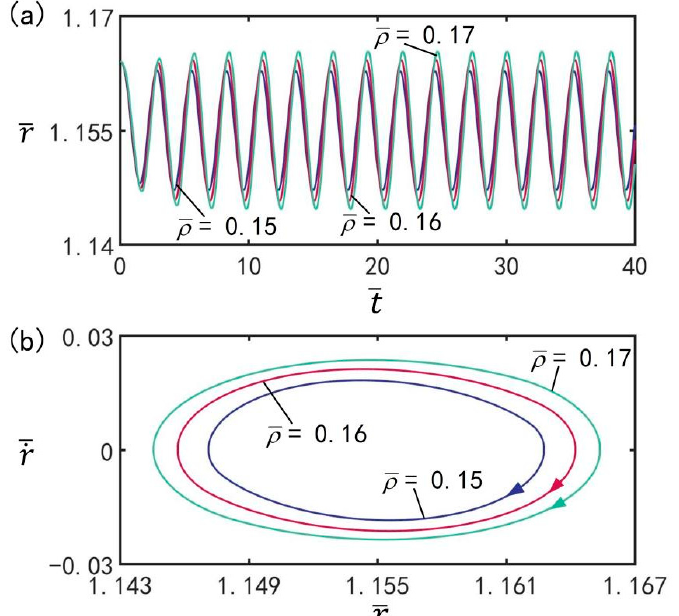
ρ Figure 10. The effect of mass density on the beating of LCE balloon. ( a ) Time histories; ( b ) Limit Figure 10. The effect of mass density ρ on the beating of LCE balloon. ( a ) Time histories; ( b ) Limit cycles. The parameters are T on / T L = 0.5, T L = 2.7, I = 0.5, C 0 = 0.3, n I = 0.45 ( r I = 1.164 ) , cycles. = 0.18, V = 0.05, β = 0.14, and . r = 0. With increasing balloon mass density, the beating p L I ext amplitude